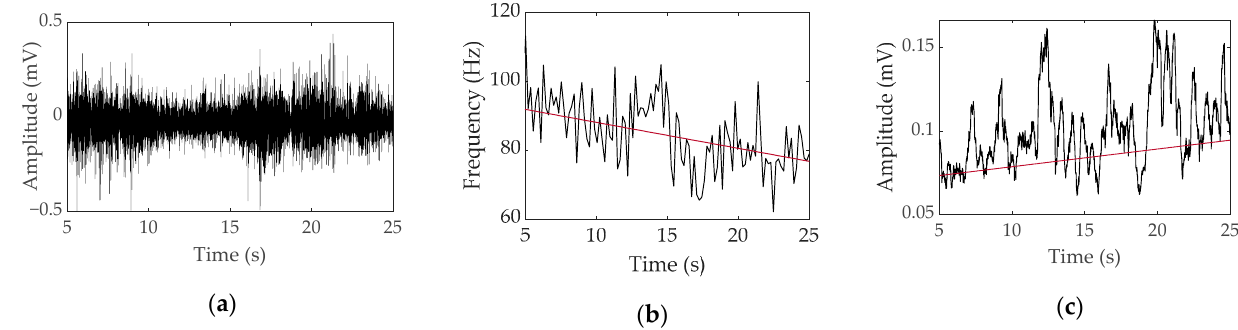
Figure 3. Surface EMG data obtained during voluntary contraction of a bicep with a 1-kg weight for a female: ( a ) raw data, ( b ) median frequency and linear regression, and ( c ) root mean square and linear regression.